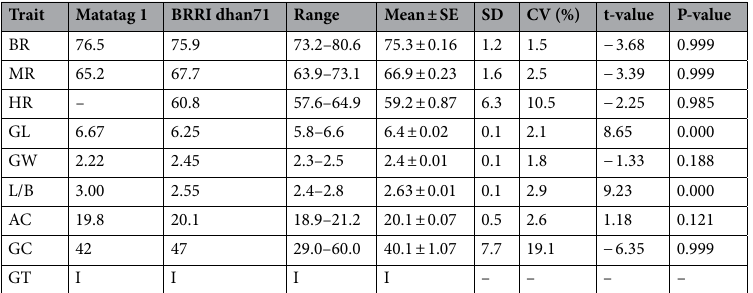
Table 4. Variation for grain quality traits in the ILs. BR—brown rice (%), MR—milled rice (%), HR—head rice recovery (%), GL—grain length (mm), GW—grain width (mm), L/B—length and breadth ratio,